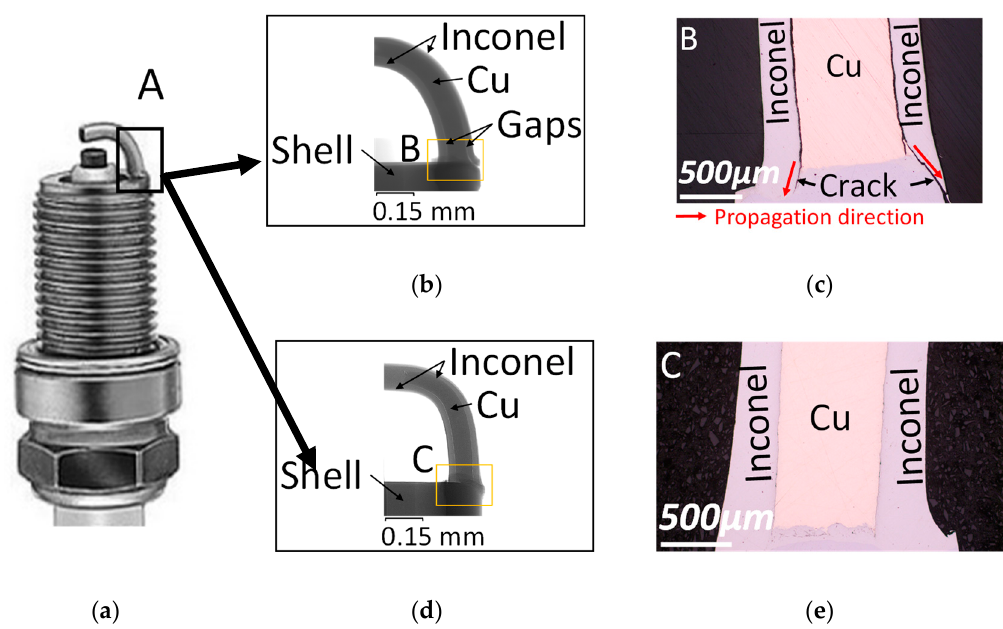
Figure 2. ( a ) Spark plug, Tomographic ( b , d ) and light microscopic ( c , e ) observations of the welded zone after bending (zone A in ( a )). After cold forming, the ground electrode ( d , e ) was cleaned prior to the annealing treatment under lab conditions (Section 2.1).